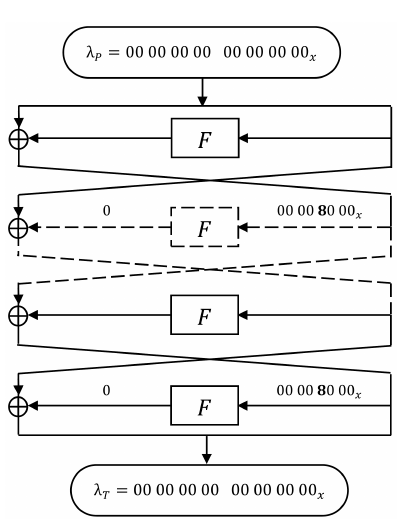
Figure 22: The Scattered Conditional Approximation λ 13 (4 Rounds of